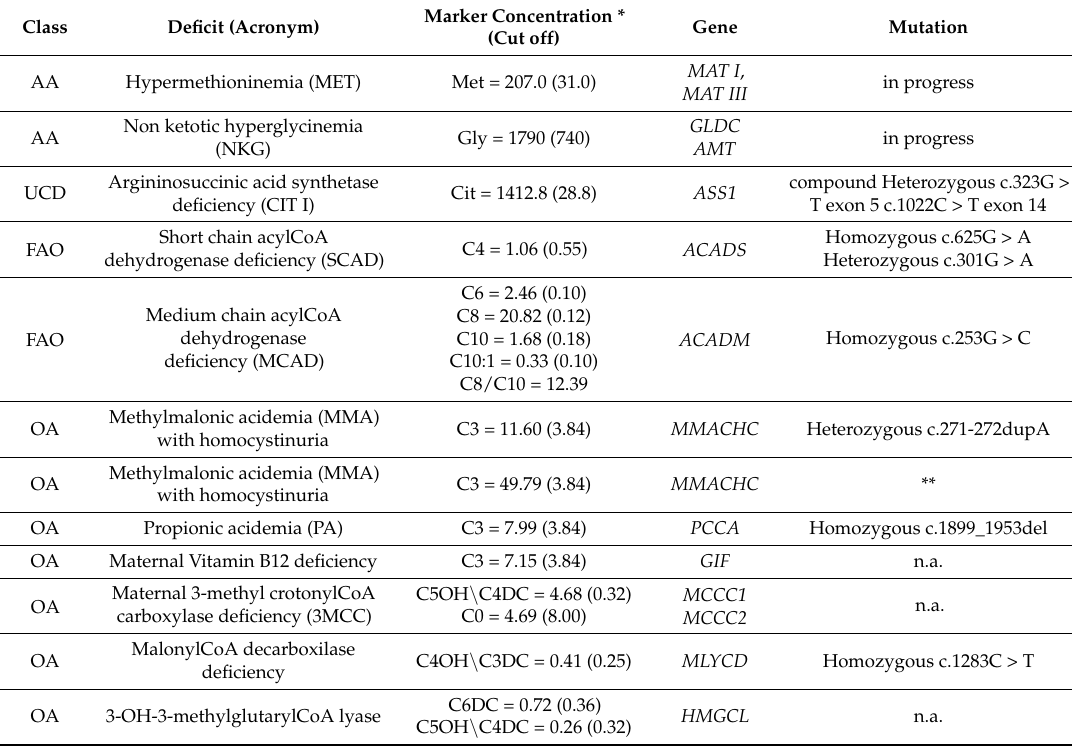
Table 2. The clinical cases diagnosed by newborn screening using tandem mass